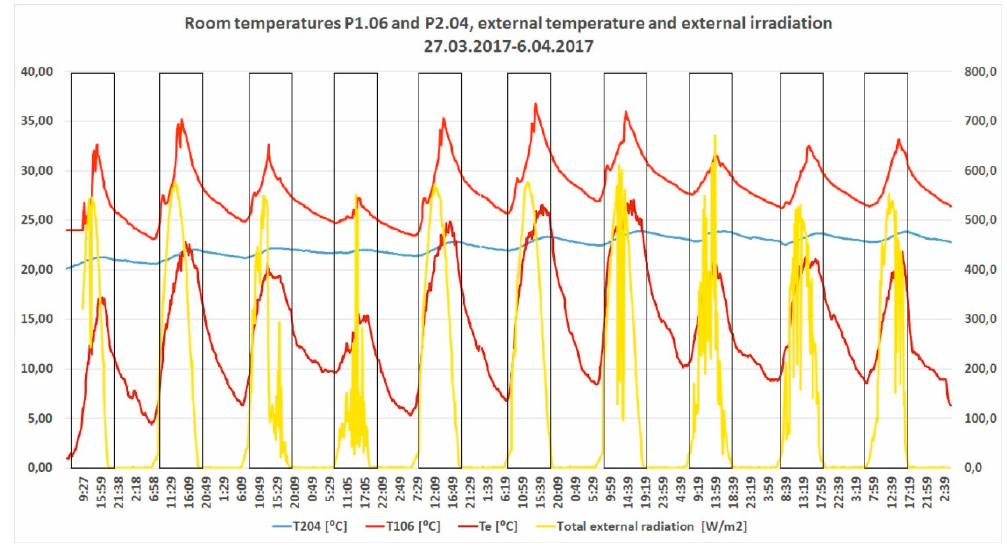
Figure 11. Wavelength of external radiation and indoor temperature in room P2.04—with external sun shading devices.